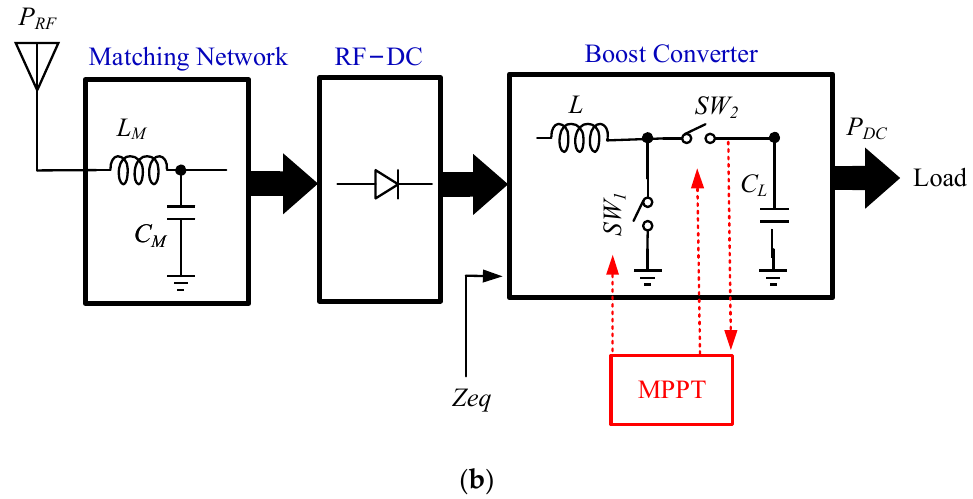
Figure 15. MPPT for RF–DC: ( a ) with adaptive matching network; ( b ) with cascaded boost converter for adaptive load control [30].